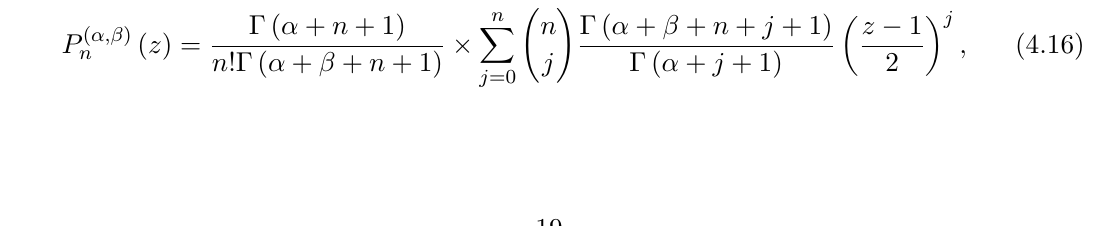
Figure 12. Data covariance in the real (a) and imaginary (b) components of the matched ITD at 2 GeV, normalized according to Cov are ordered in ascending Wilson line